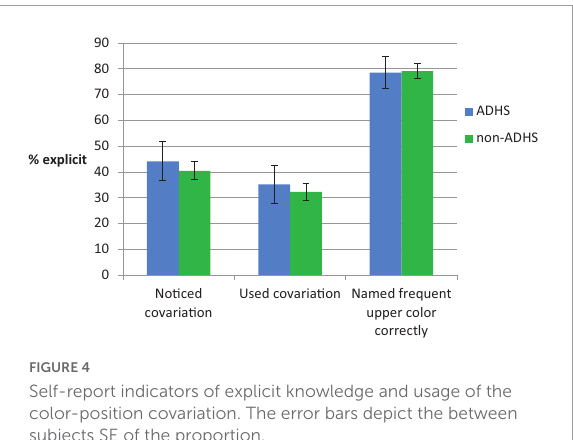
FIGURE4 Self-report indicators of explicit knowledge and usage of the color-position covariation. The error bars depict the between subjects SE of the